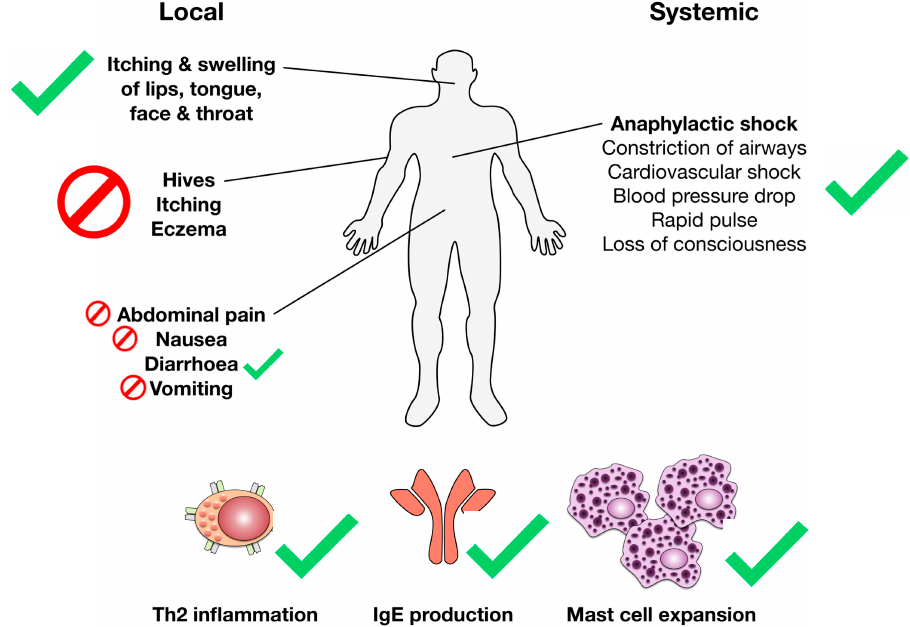
Figure 6. Reproduction of the immunological and clinical parameters associated with food allergic reactions by the available mouse food allergy models. Human immunological and clinical food allergy parameters that can be recreated by the available mouse food allergy models (anaphylactic shock and the associated parameters and symptoms, itching and swelling of lips, tongue, face, and throat, diarrhea caused by allergic intestinal inflammation, and the immunological parameters of the allergic Th2 reaction (Th2 inflammation, IgE production, as well mast cell activation, degranulation, and expansion)) are marked with green checkmarks, parameters that have up to now proven di ffi cult to reproduce in mice (the often with food allergic reactions associated skin reactions (hives, itching, and eczema), abdominal pain, and nausea) are marked with red stop signs. Please note that mice are anatomically unable to vomit.